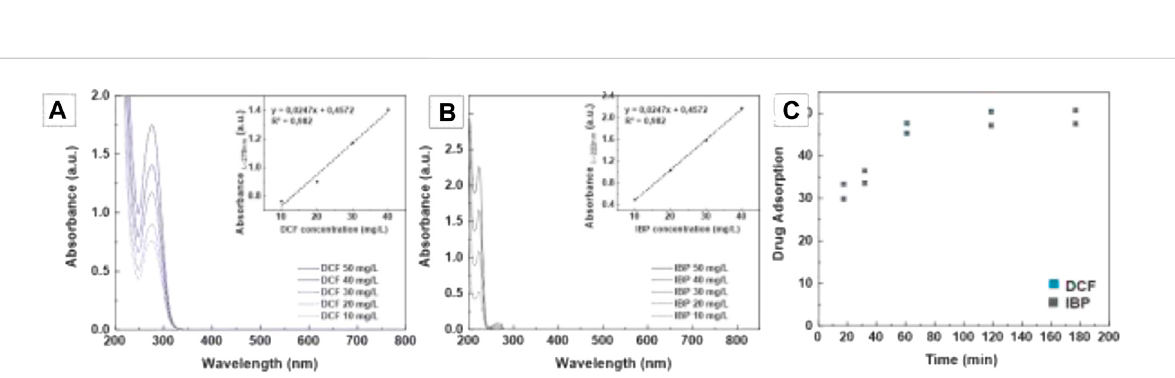
FIGURE 4 Calibration curves of IBP (A) and DFC (B) compounds. Time evolution experiment of Graphene Hybrids when exposed to different drugs (C) . Aliquots containing 1 g/L (3.2 · 10 15 NPs/g graphene) Graphene hybrids were exposed to 100 mg/L and 68 mg/L for IBP and DCF solutions for different times. Adsorptionwascalculatedfrom the abatementof theUV-Vis signal of the supernatant resulting from centrifuging the samples at 10,000 g for 10 min. DCF signal was monitored at 275 nm, while IBP signal was observed at the characteristic band at 222 nm and its temporary products at 264